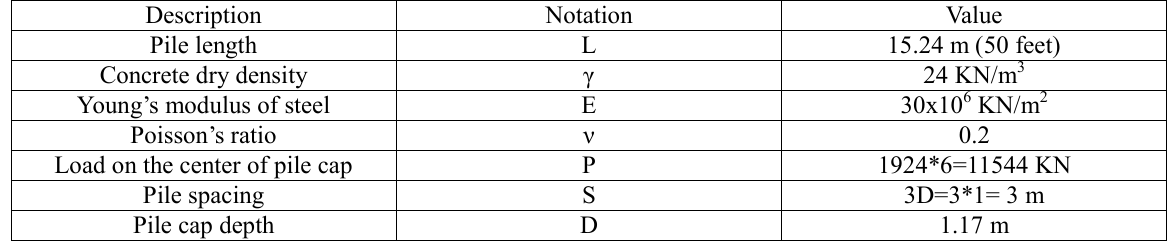
Specifications of group of six piles (P